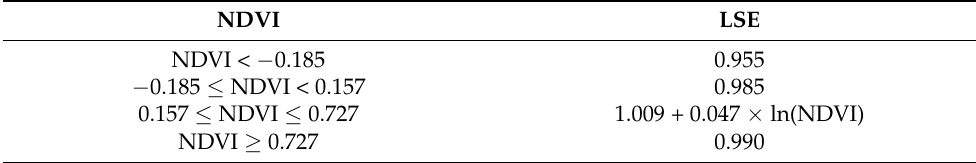
Table 2. Emissivity values based on